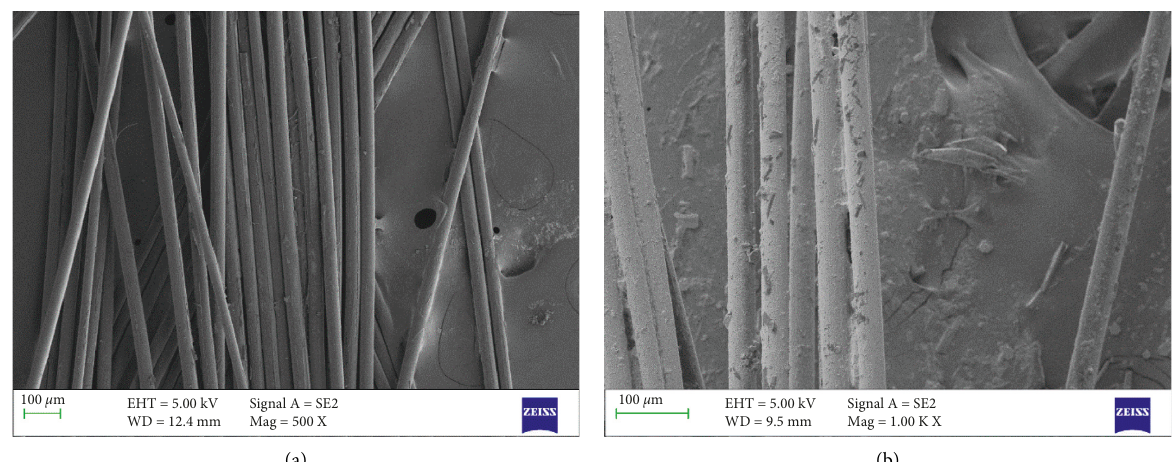
Figure 8: (a) SEM of raw PVA fiber. (b) SEM of SPS-dipped PVA fiber.